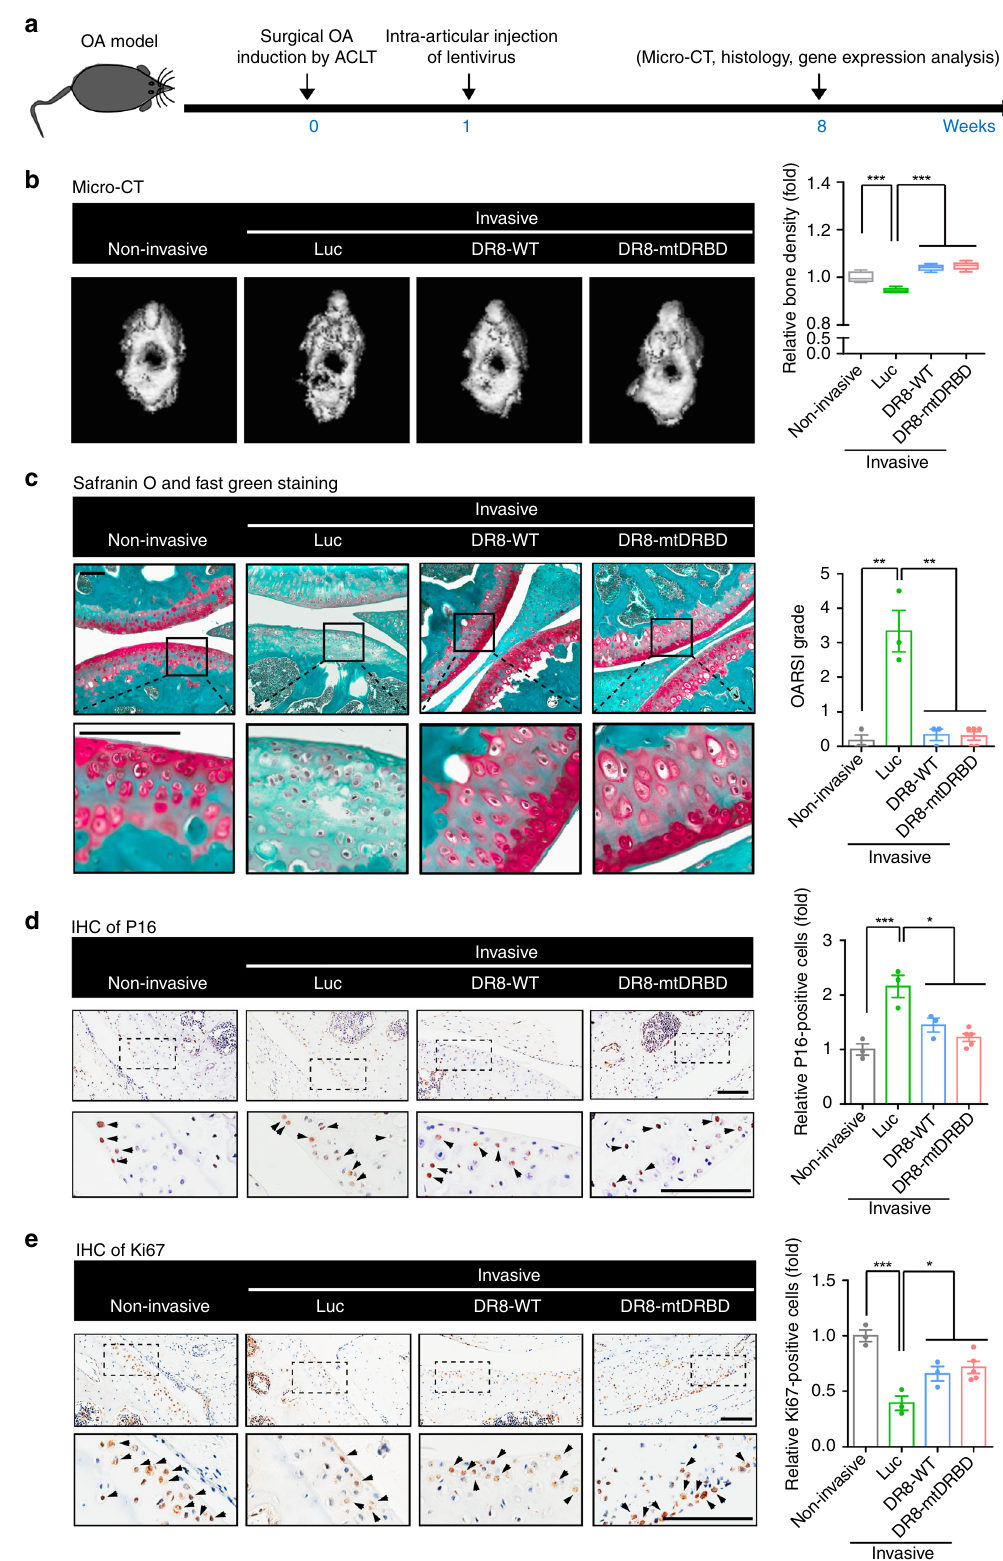
N-terminus of DGCR8, had normal self-renewal ability and pluripotency, but compromised proliferation upon differentiation into hMSCs. The diverse characteristics related to different DGCR8 defects suggest that the regulatory activities by DGCR8 are cell-type and developmental-stage dependent.